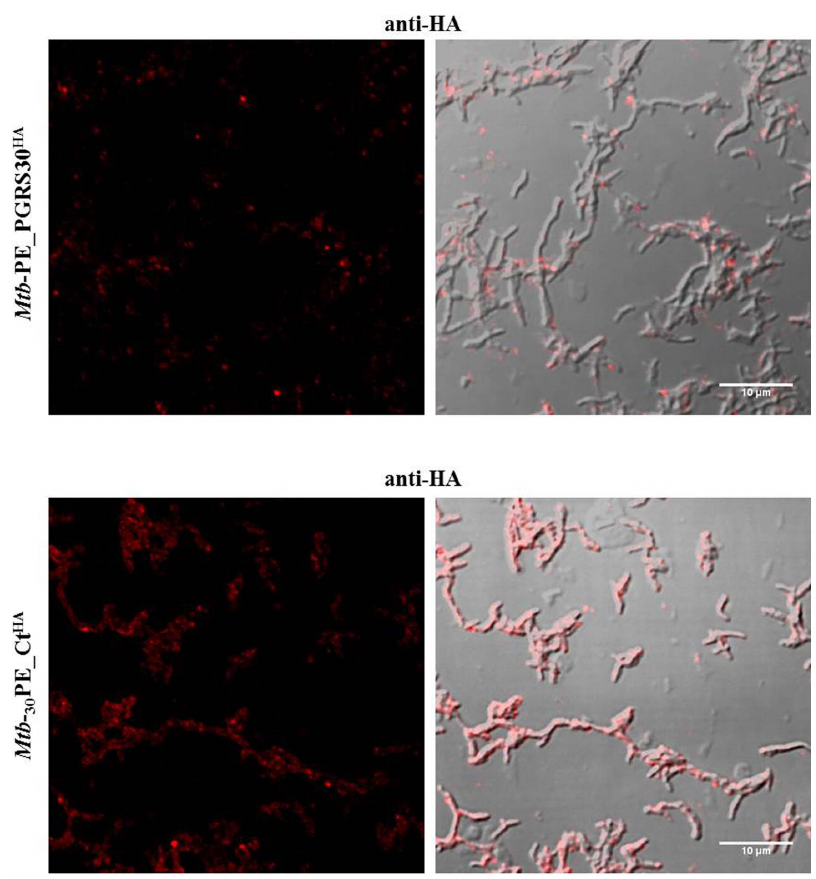
Figure 5. Immunofluorescence using anti-HA antibodies. Mtb -PE_PGRS30 HA (A) and Mtb - 30 PE_CT HA (B) were subjected to immunofluores- cence using anti-HA antibodies. Confocal images were acquired with a 63 6 oil immersion objective and localization was evaluated with ImageJ software using overlap between red channel (left panel) and transmission images.